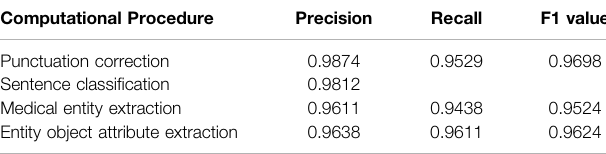
TABLE 2 | Effect of each calculation step of